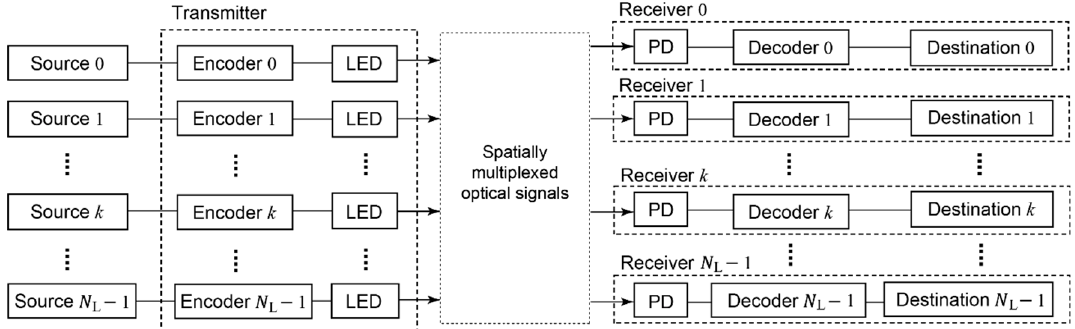
Figure 1. Model of an optical CDMA system.